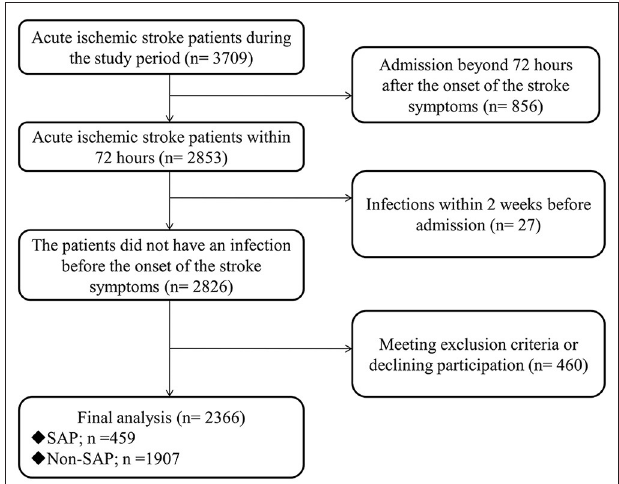
FIGURE 1 | The flow of patients. SAP, stroke-associated